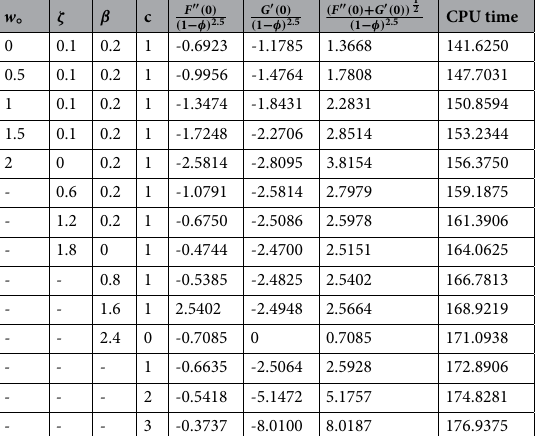
0.05 of TiO 2 water . = −